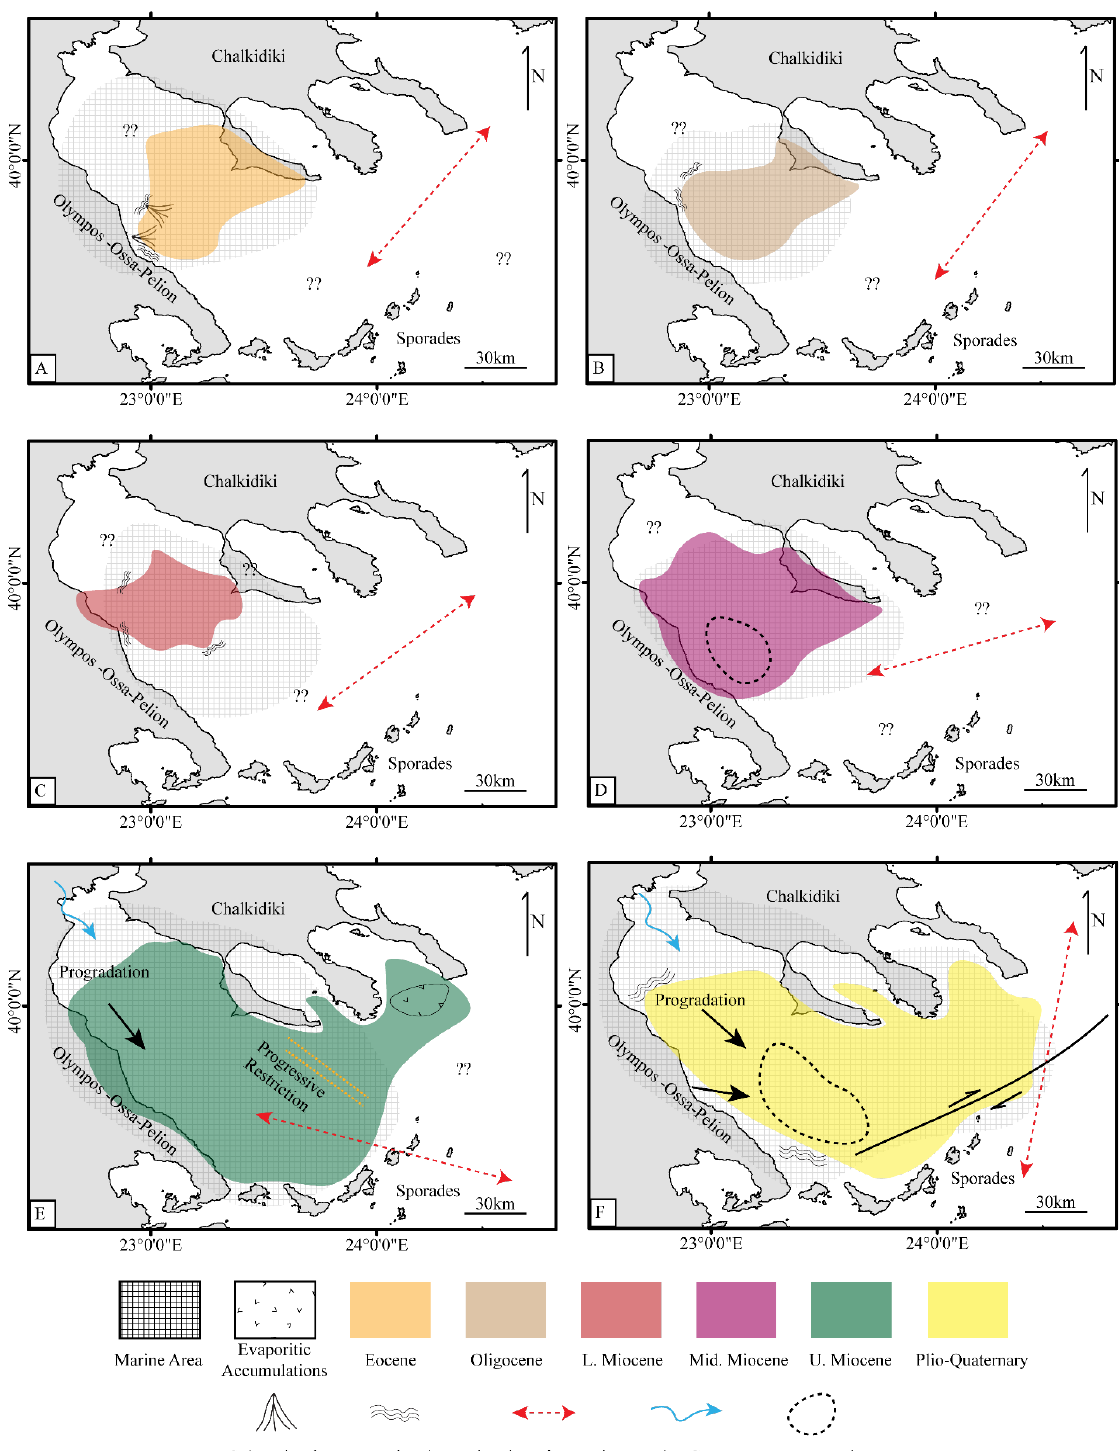
Figure 14. Schematic maps of the paleogeographic basin reconstruction during the various stratigraphic intervals: ( A ) Eocene, ( B ) Oligocene, ( C ) L. Miocene, ( D ) M. Miocene, ( E ) U. Miocene, and ( F ) Pliocene-Quaternary. The extension of the coverage is constrained by the mapping of each unit in the seismic sections and their correlative extent as directed by the neighboring wells, where applicable. Extensional direction is based on the mapped faults as correlated with Brun and Sokoutis [52,53] for Paleogene–Early Miocene, Mercier et al. [55] for Upper Miocene, and Mercier et al. [55], Kahle et al. [67], and Le Pichon et al. [68] for Pliocene and